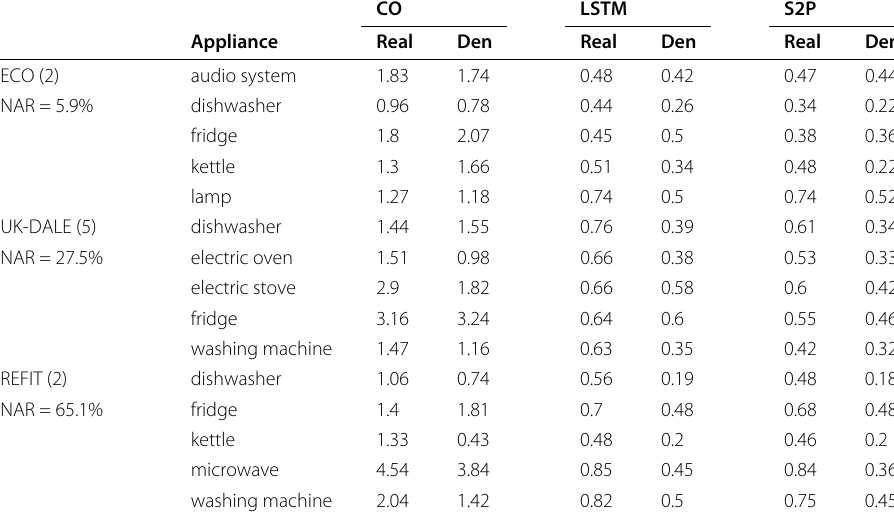
Table 4 Normalised disaggregation error (NDE) for real and denoised testing CO LSTM S2P Appliance Real Den Real Den Real Den ECO (2) NAR =